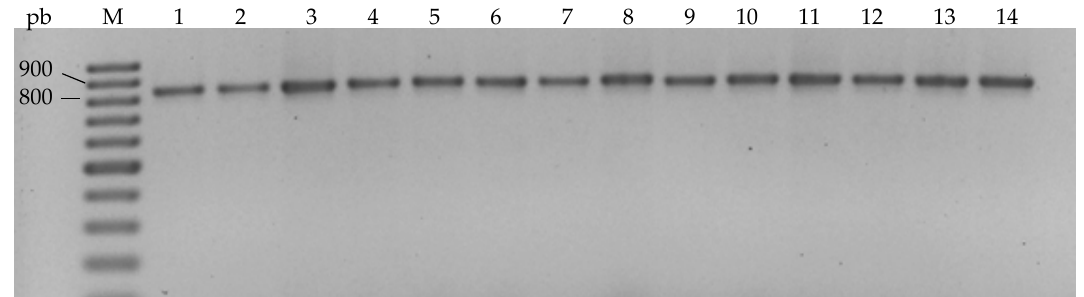
Figure 3. Amplification of ITS-5.8S region of rDNA; 1–M: 100 bp GeneRuler DNA Leader; 1–14: characteristic fragment obtained from isolated analysed; agarose gel (1.4%).